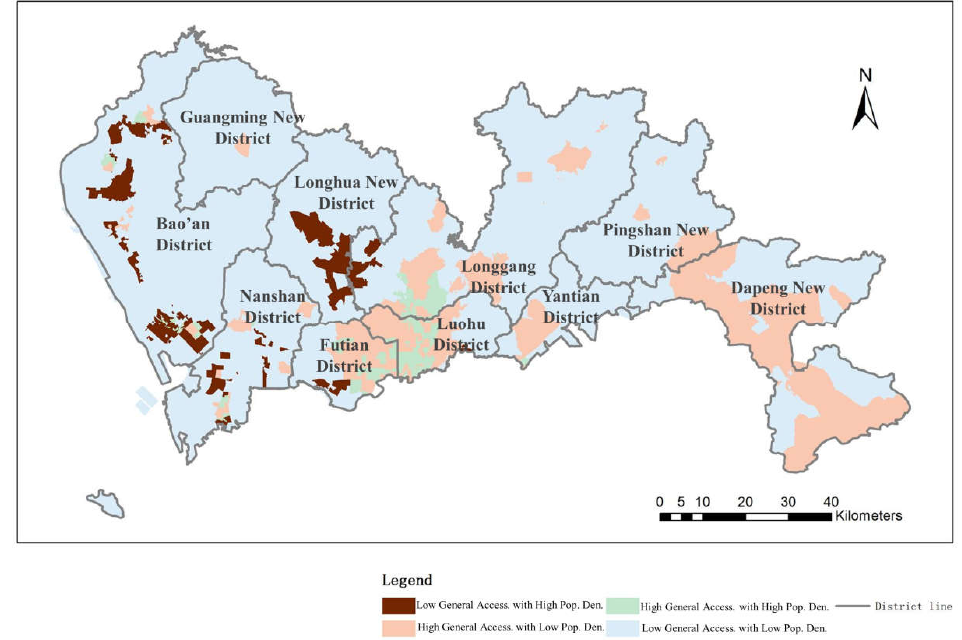
Figure 13. Balance evaluation between all medical service facility accessibility and population density levels.